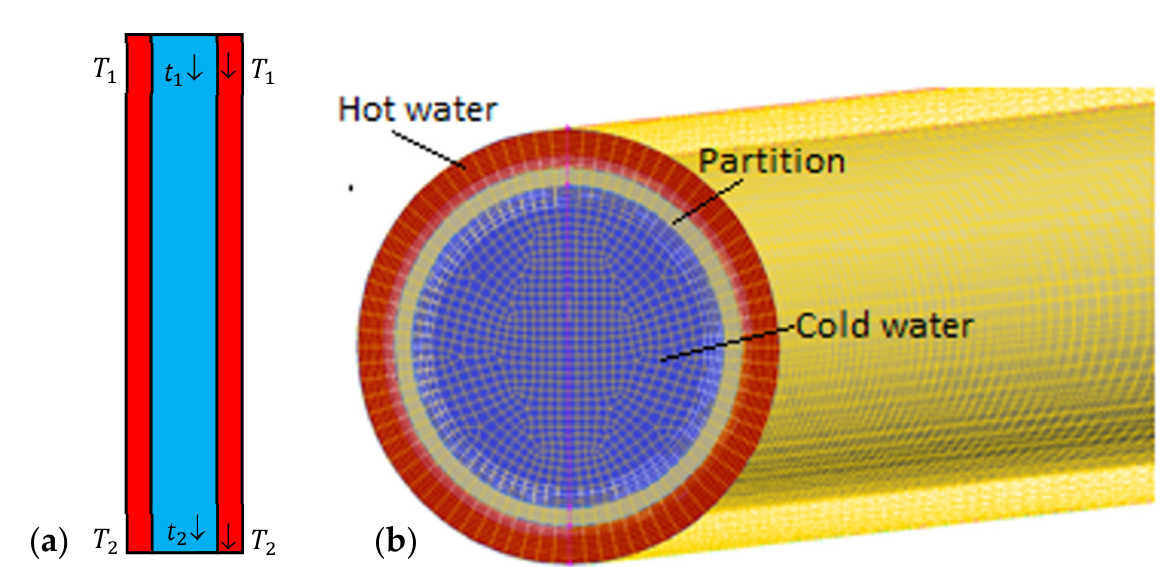
Figure 5. Stanton benchmark experiment; ( a ) cross-section, ( b ) numerical model.